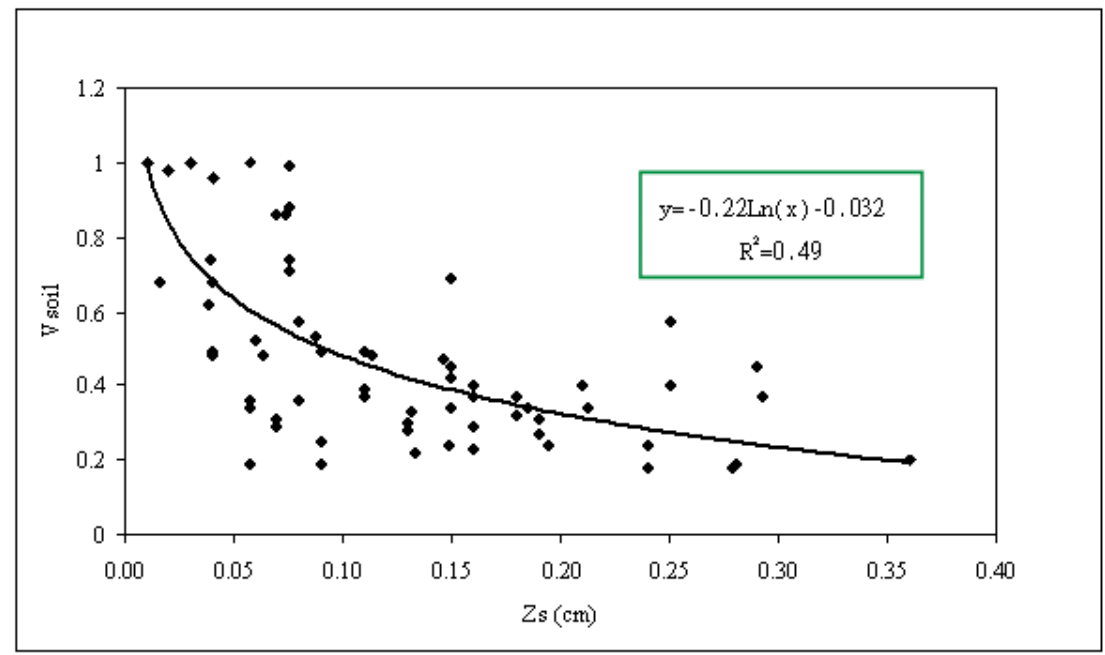
Figure 5. Variation of the  parameter